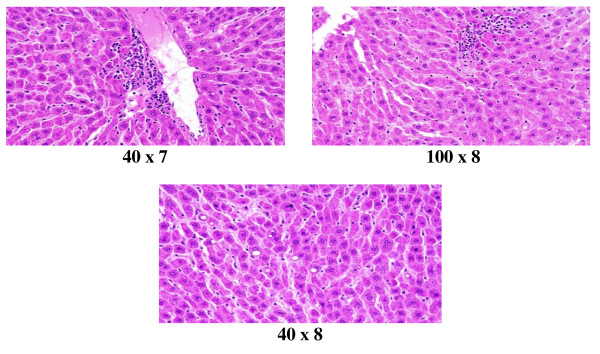
GNPs-treated rat received 100 μl of 50 nm particles for 3 days